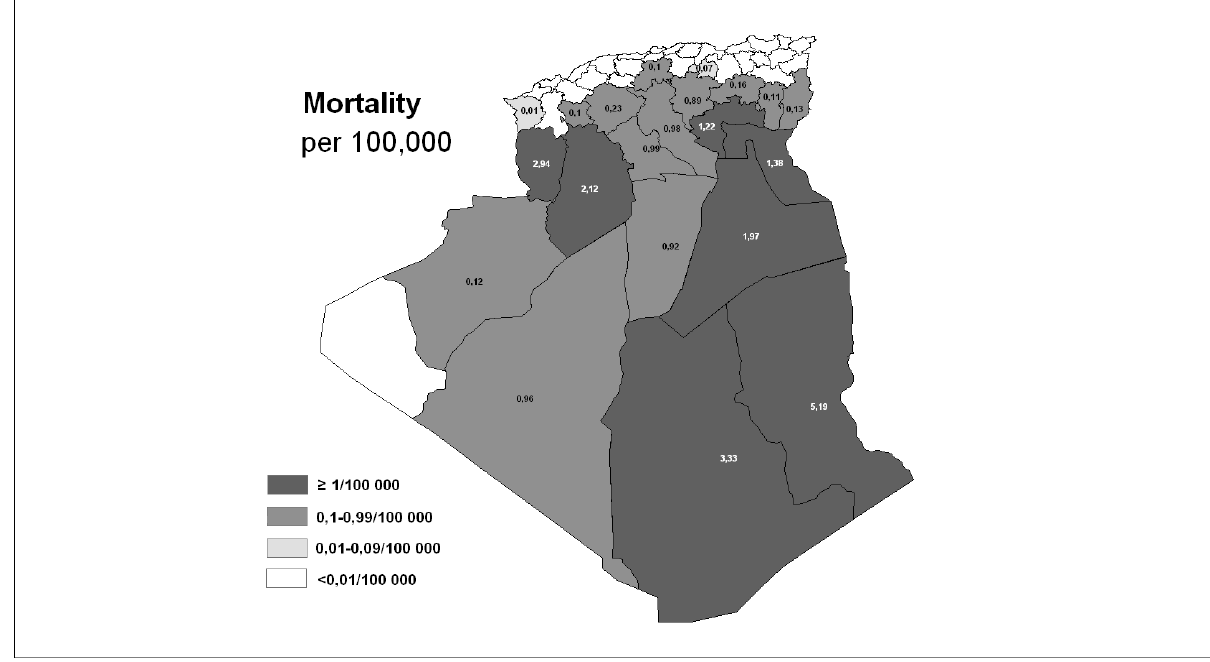
Figure 2. Geographical distribution of annual mortality due to scorpion stings in Algeria